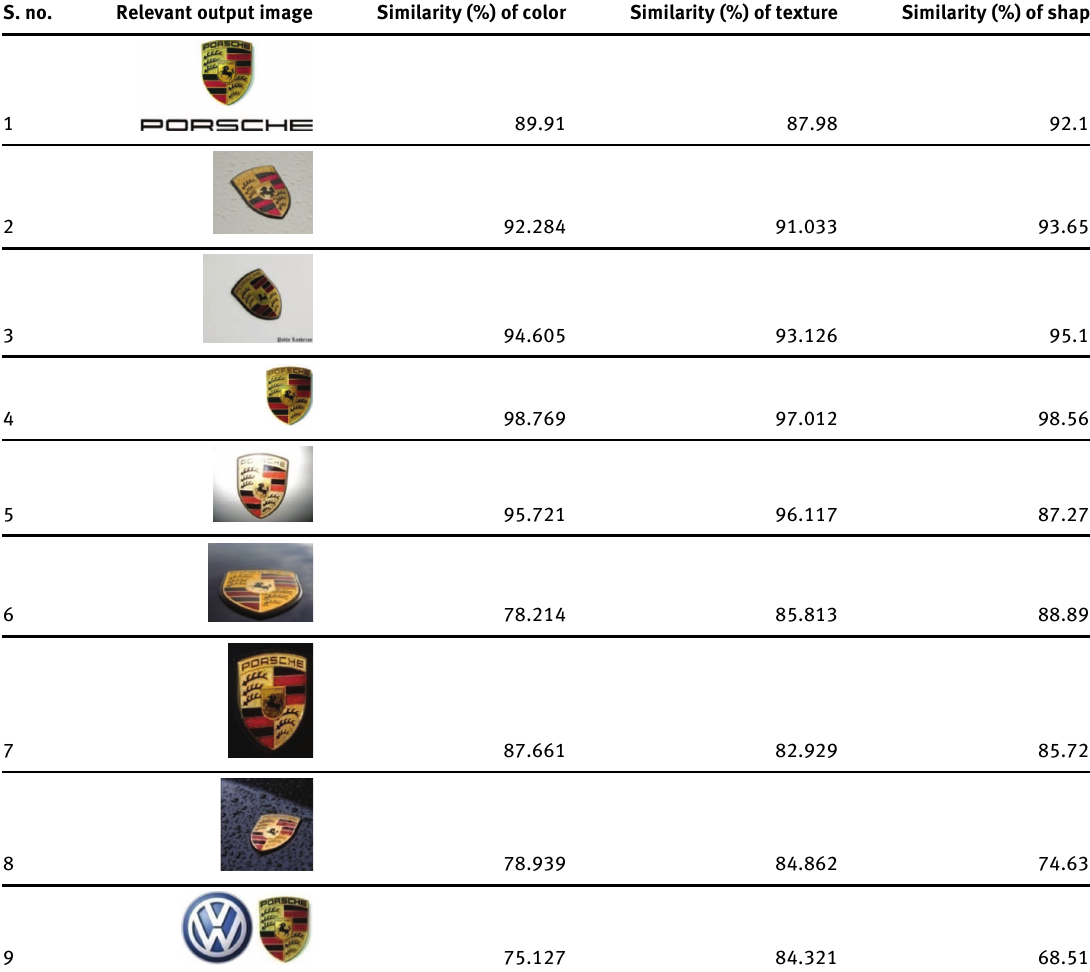
Table 7: Similarity (%) of Color, Texture, and Shape for the Topmost Nine Relevant Output Images. S. no.